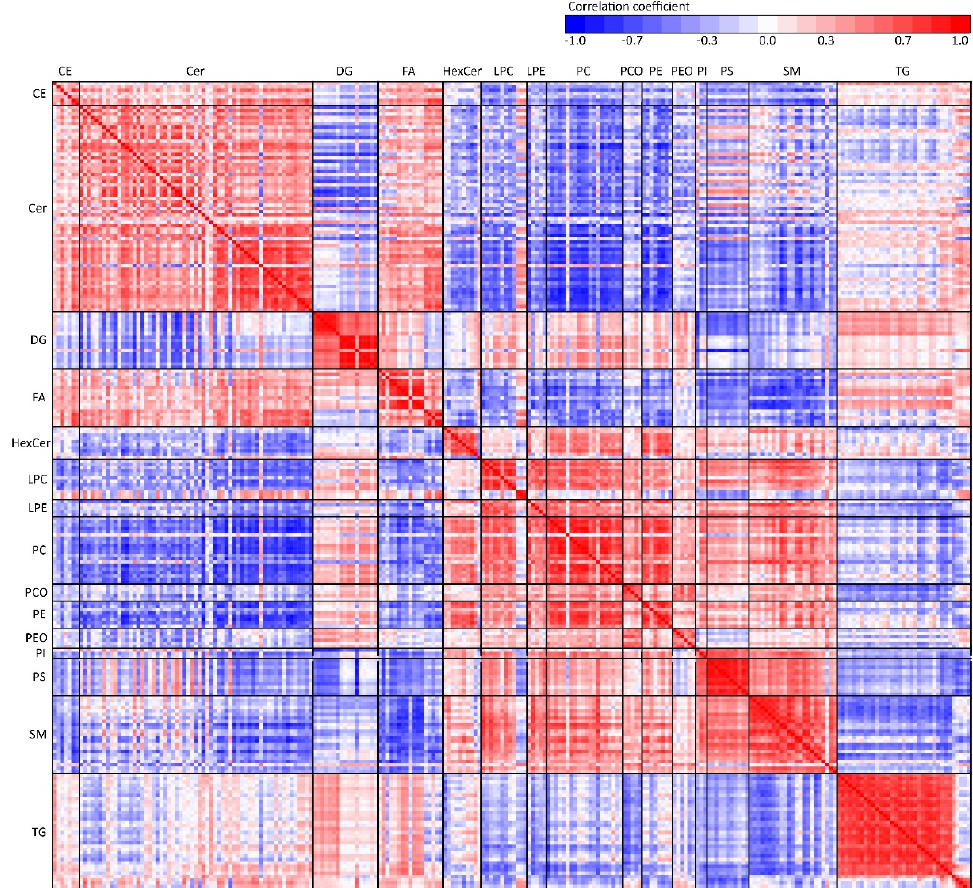
Figure 12. Heatmap of Pearson’s linear correlation coefficients between all lipid species categorized by lipid classes.